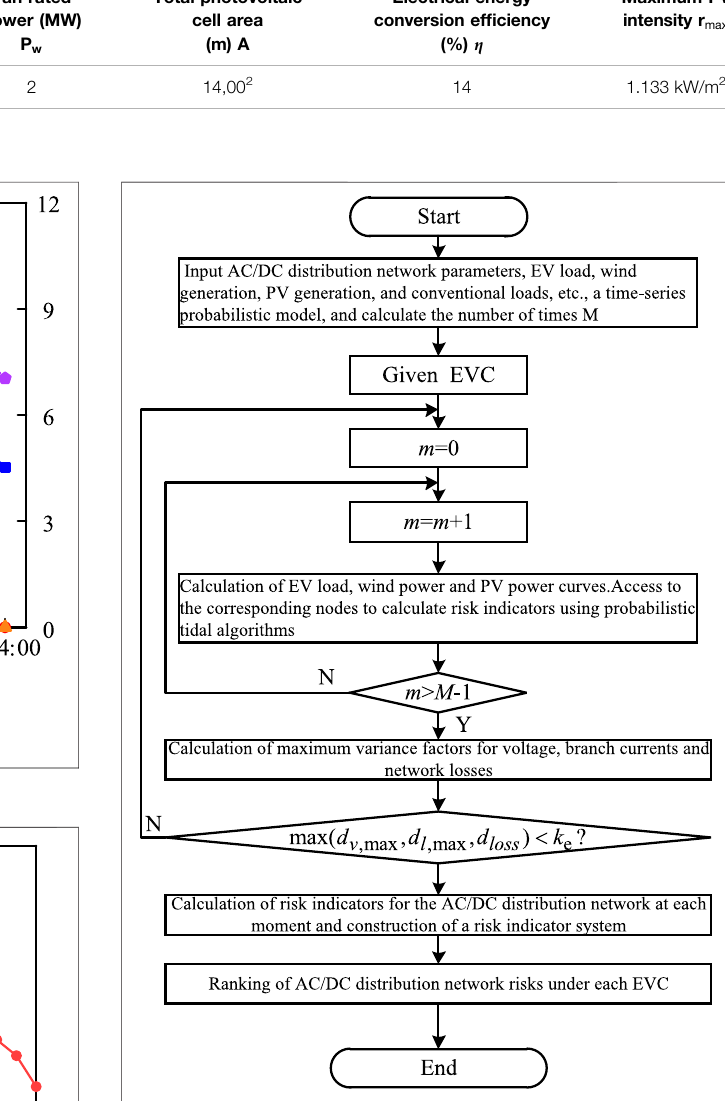
FIGURE 5 | Calculation process of distribution network operation